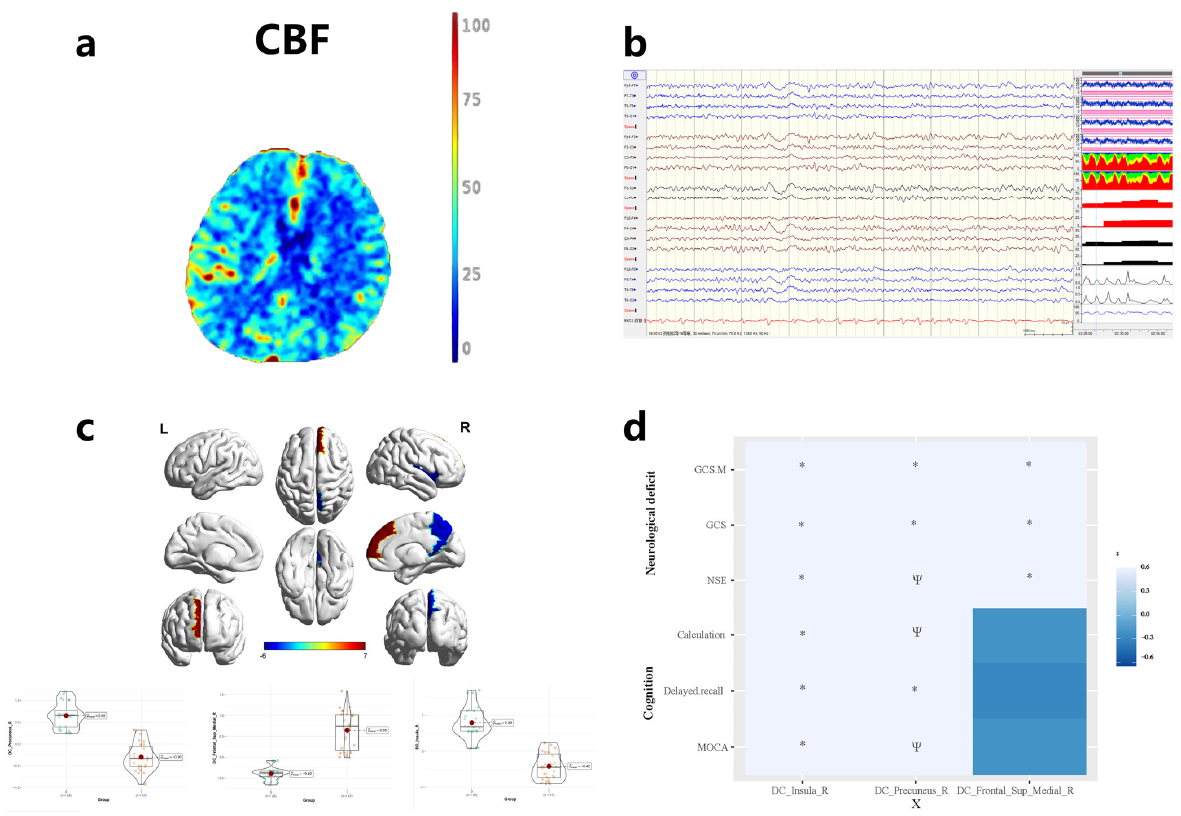
Figure 2. ( a ) Cerebral blood flow image of Cranial Computed Tomography perfusion after ECMO